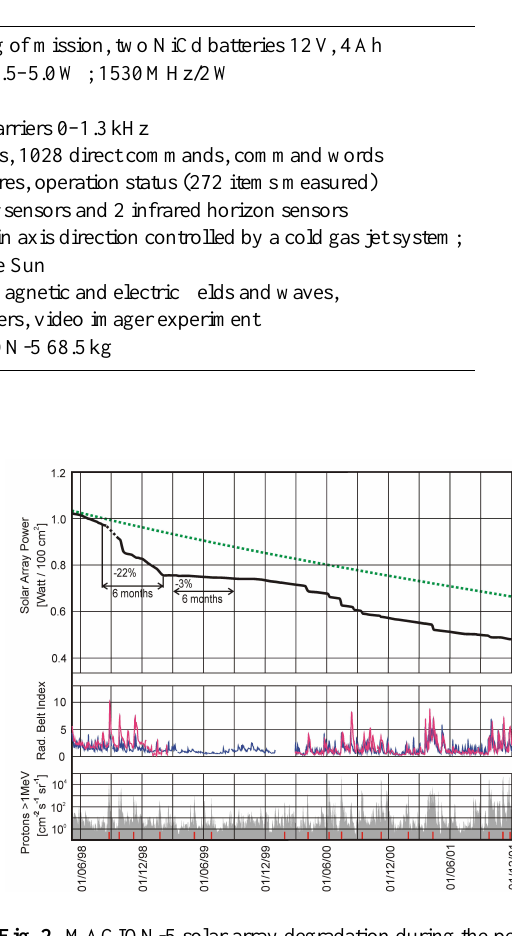
Fig. 2. MAGION-5 solar array degradation during the period from May 1998 to July 2002. The two curves in the central part of the figure show the radiation belt indices based on NOAA POES data: > 30keV (red) and the > 300keV (blue) electrons. Daily proton flux values measured by FOES-8 are shown in the lower panel. So- lar proton events are denoted by red marks on the time scale. Note: most of the step-like decreases in the solar cells’ output power are connected with strong solar proton events; periods with a steeper decrease in the output power correspond to periods of enhanced ra- diation belt